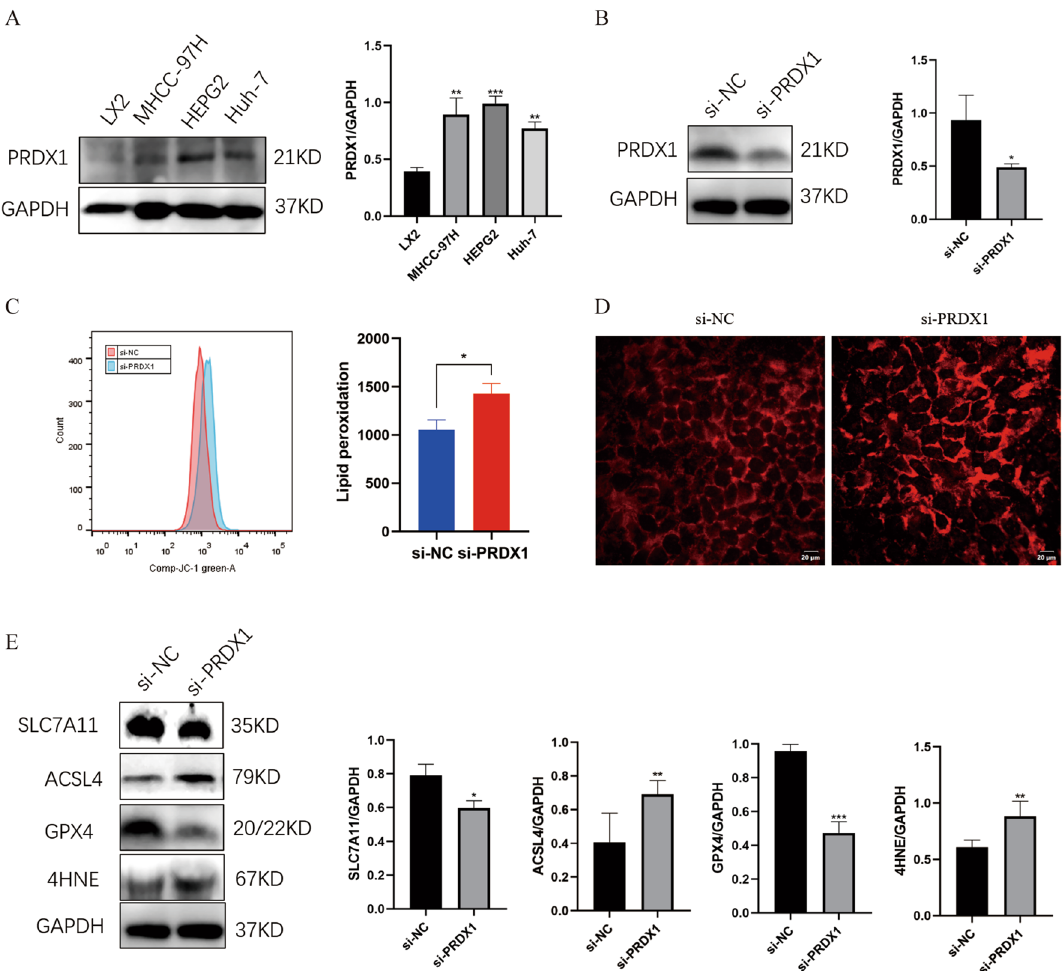
Figure 9. PRDX1 expression is upregulated in hepatocellular carcinoma cell lines and silencing PRDX1 promotes ferroptosis in hepatocellular carcinoma cells. ( A ) The PRDX1 expression levels in hepatocellular carcinoma cell lines using Western Blot. ( B ) PRDX1 was successfully knocked down by siRNA. ( C ) HEPG2 cells had elevated lipid peroxidation levels after silencing PRDX1. ( D ) HEPG2 cells had higher levels of Fe2+ after silencing PRDX1. ( E ) western blot showed decreased expression levels of SLC7A11 and GPX4 and increased expression levels of 4HNE and ACSL4 in HEPG2 cells after silencing